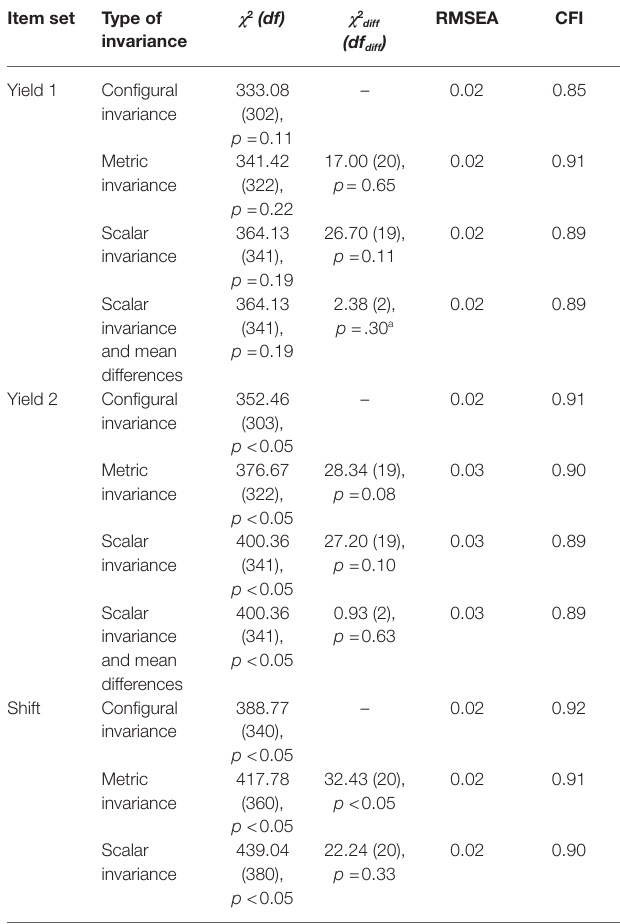
TABLE 7 | Fit of models for the investigation of measurement invariance for gender.